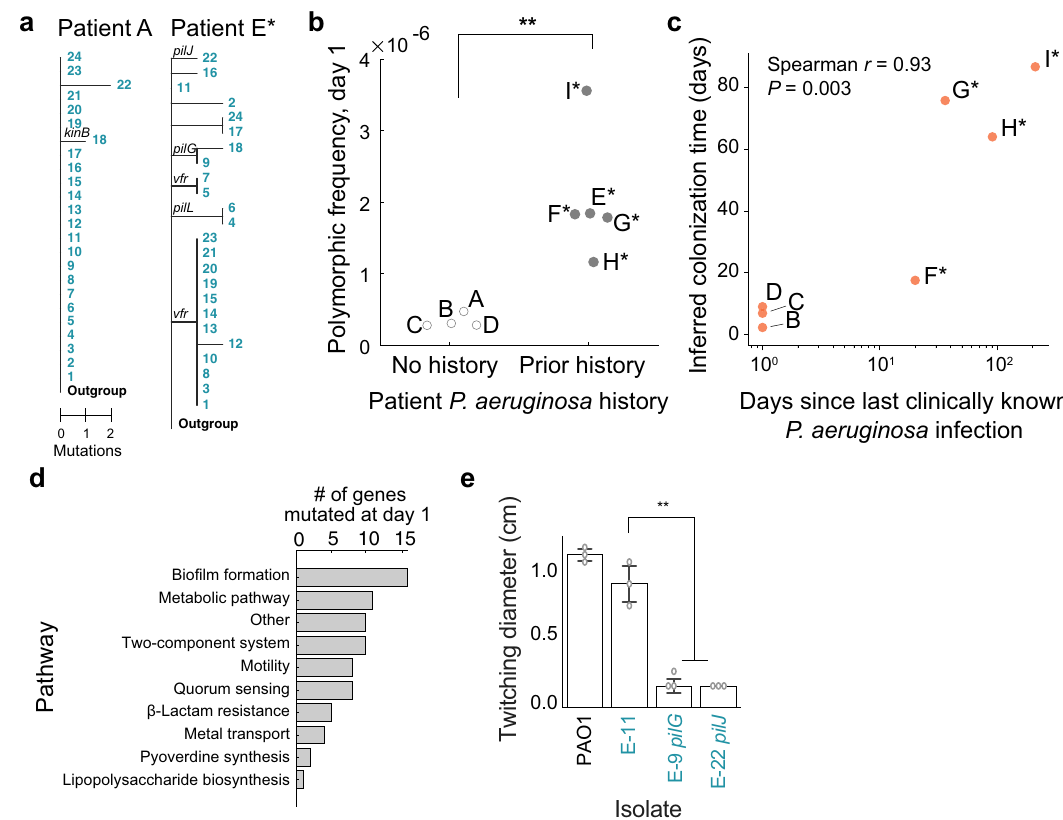
Fig. 2 Patient infection history impacts genomic diversity of P. aeruginosa at the onset of infection. a Phylogenetic trees of P. aeruginosa populations in pilot patients A and E* rooted with an Outgroup (Methods). Numbers (rows) correspond to tree leaves (teal) representing an isolate. Scale: mutational events (single nucleotide polymorphisms (SNPs) and indels) from the most recent common ancestor (MRCA) in each patient. Select branches are labeled with mutated genes. b Comparing the initial pathogen diversity of patients (dots) based on prior history of P. aeruginosa infection. Frequency of polymorphic loci ( y -axis; calculated as number of unique SNP or indel positions divided by genome size) in patients with no prior P. aeruginosa history vs. in patients with clinically documented infection history ( x -axis). Signi fi cance: P = 0.007, two-sided t -test. c Relation between the estimated colonization time of the pathogen in each patient (days, y -axis; Methods) and time to the last clinically documented infection (days, x -axis). Spearman correlation (two- sided), r = 0.93, P = 0.003. d Pathways ( y -axis) found in mutations of coding regions at day 1 ( x -axis) across all patients. e Altered twitching phenotype in isolates with single point mutations in genes of the pil locus. Isolates ( x -axis) assayed for twitching diameter (cm, y -axis; Methods), from left to right: PAO1 reference strain, E-11 isogenic control, E-9 singleton pilG mutant, E-22 pilJ singleton mutant. Each assay was conducted across 3 technical replicates (dots), representative of 3 biologically independent replicates. Bars show median; error bars, standard error (s.e.). Signi fi cance: Tukey ’ s multiple comparisons test (E-11 vs. E-9, P = 0.001; E-11 vs. E-22, P = 0.001; adjusted P-